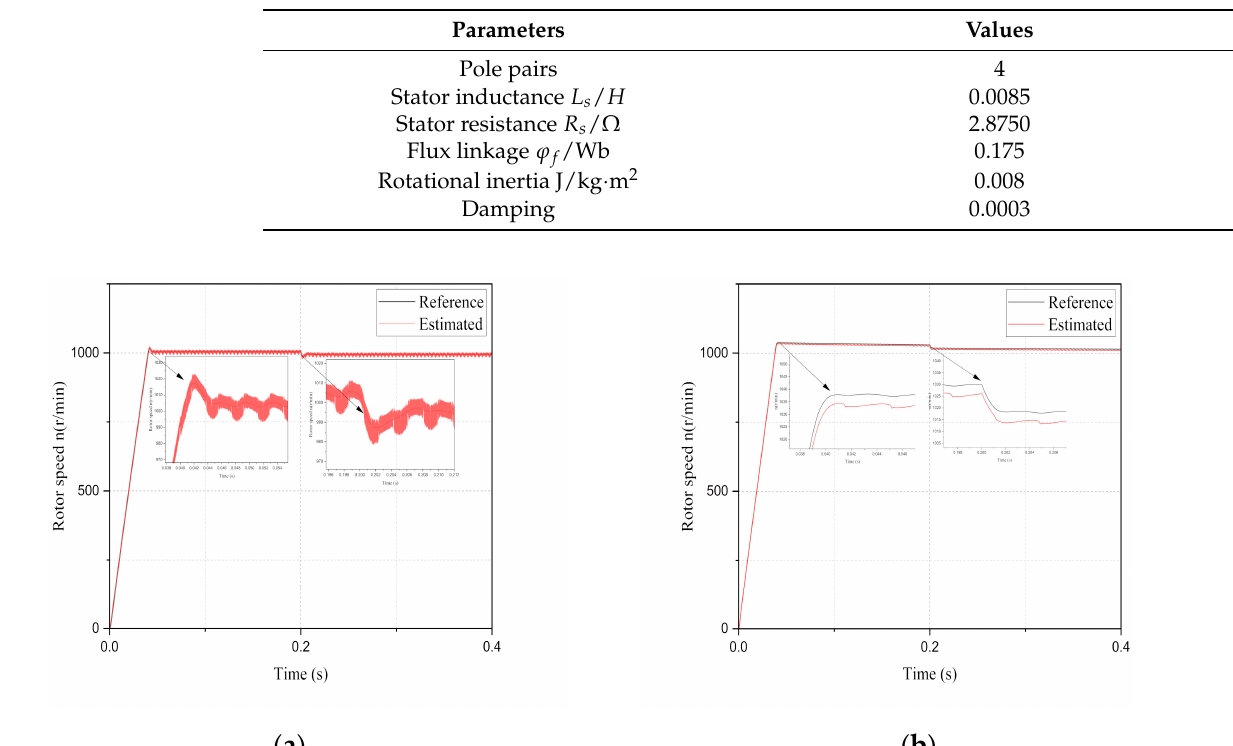
Table 2. PMSM parameters.